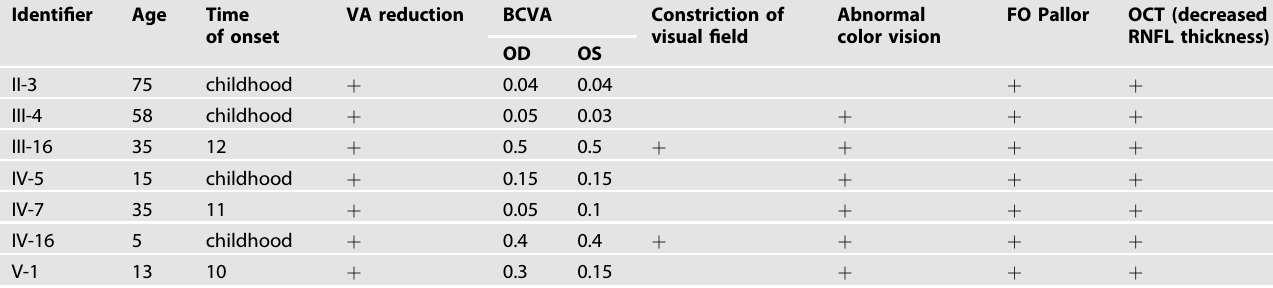
Table 1. Clinical characteristics of patients with p.F175S (c.524T<C) mutation in this